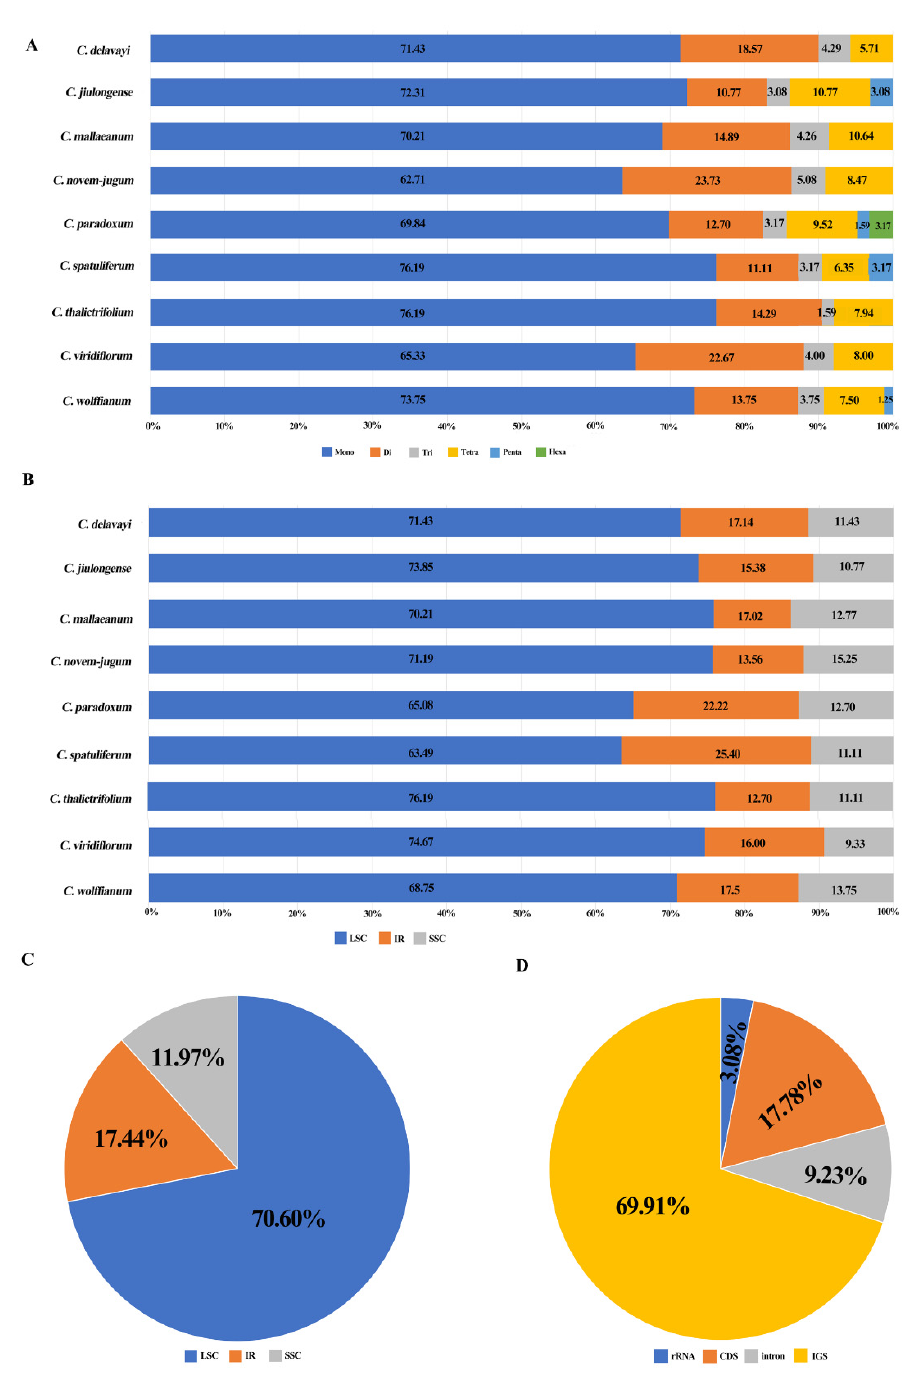
Figure 4. Analysis of simple sequence repeats (SSRs) in nine Chamaesium plastid genomes. ( A ) Frequency of identified SSR motifs in different repeat type classes in nine species, ( B ) frequency of identified SSR motifs in LSC, IR, SSC of nine species, ( C ) proportion of repeats in LSC, IR, SSC in total, ( D ) proportion of repeats in tRNA or rRNA, CDS, intron and intergenic spacer (IGS) in total.